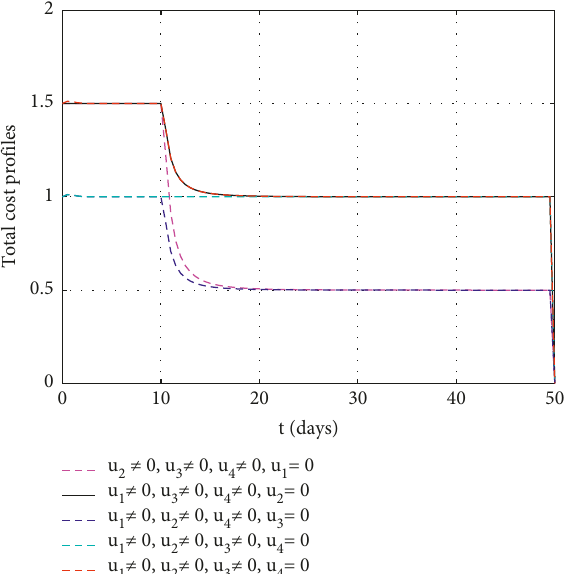
Figure 11: Simulations of cost of applied control measures.